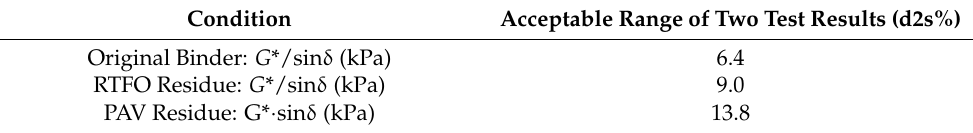
Table 3. Repeatability of dynamic shear